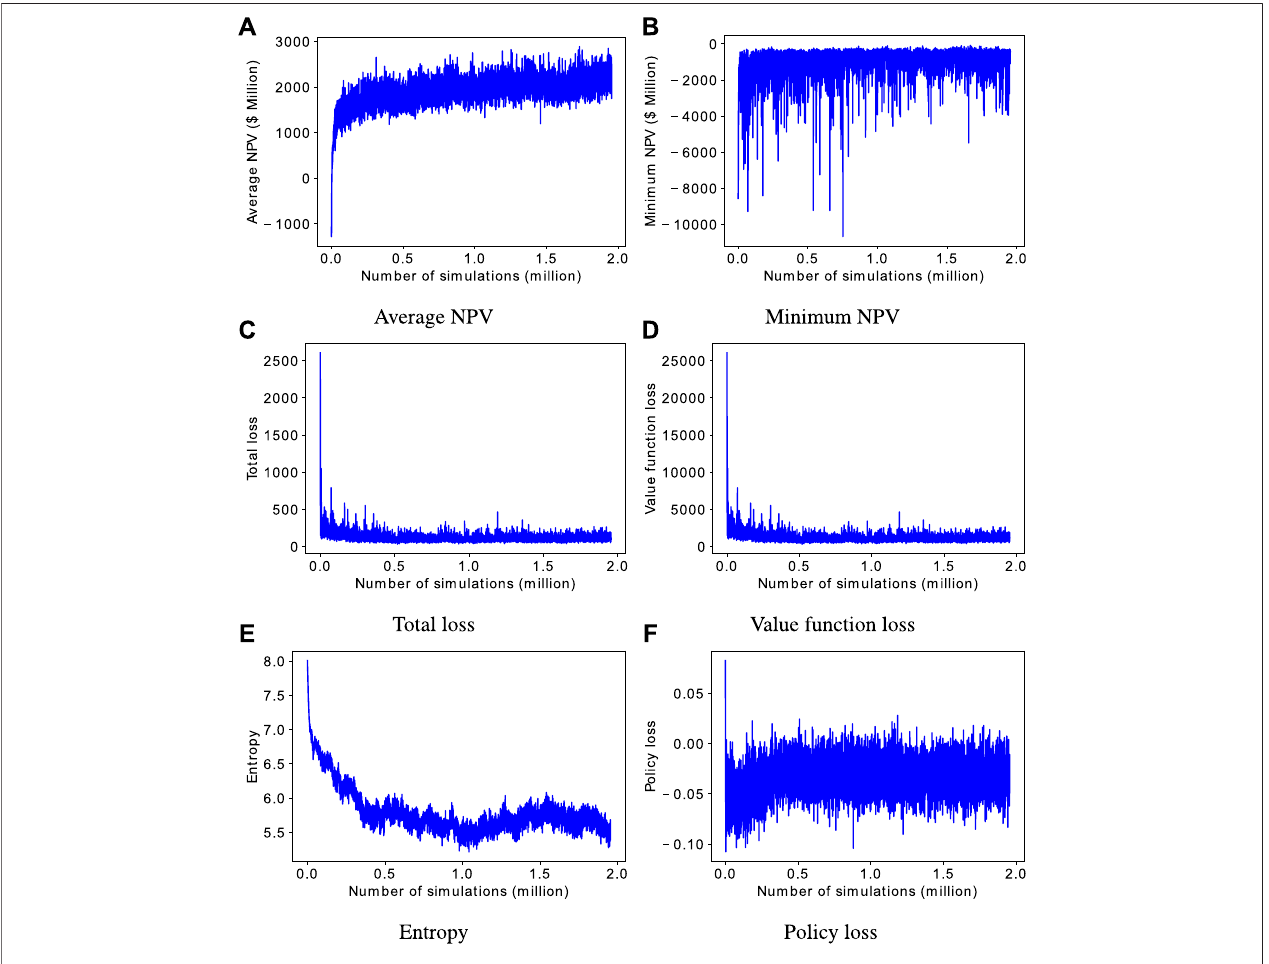
FIGURE 4 | Evolution of training performance metrics for the dual-action probability distributions for the 2D case.